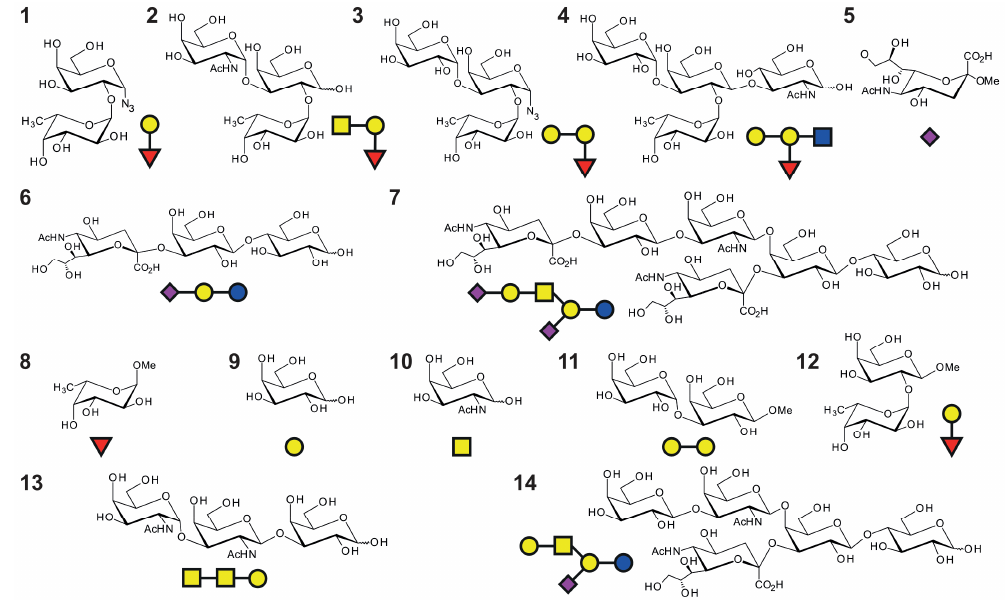
Scheme 1. Oligosaccharides used in this study. 1 and 12 : blood group H-disaccharide; 2: blood group A trisaccharide; 3 : blood group B trisaccharide (azido group at the anomeric position); 4 : blood group B tetrasaccharide (reducing form); 5 : methyl glycoside of N -acetyl α -D-neuraminic acid (sialic acid); 6 : 3 (cid:48) -sialyllactose (3 (cid:48) SL, glycan part of GM3 ganglioside); 7 : glycan part of GD1a ganglioside; 8 : methyl α -L-fucopyranoside; 9 : D-galactose; 10 : N -acetyl D-galactosamine; 11 : Galili epitope; 13 : Forssman antigen; 14 : glycan part of GM1a